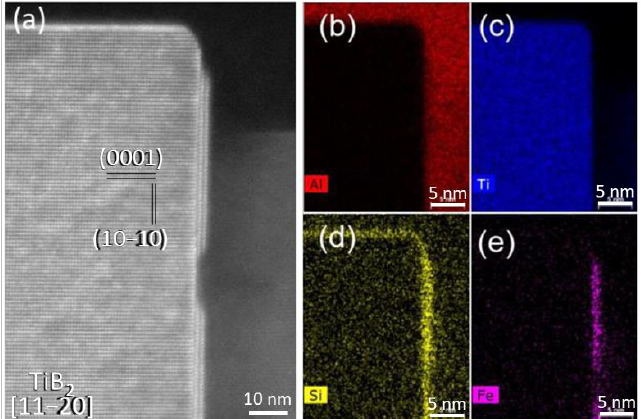
Figure 21. Segregation of Fe and Si at Al/TiB 2 interface [64,68]. ( a ) High resolution STEM HAADF image across Al/TiB 2 interface viewed along [1 1 2̅ 0]TiB 2 direction; ( b – e ) super-X EDS elemental mapping of ( b ) Al, ( c ) Ti, ( d ) Si, and ( e ) Fe showing that Si segregates on all surface of TiB 2 but Fe segregates only on (1 0 1̅ 0) prismatic surface of TiB 2 .